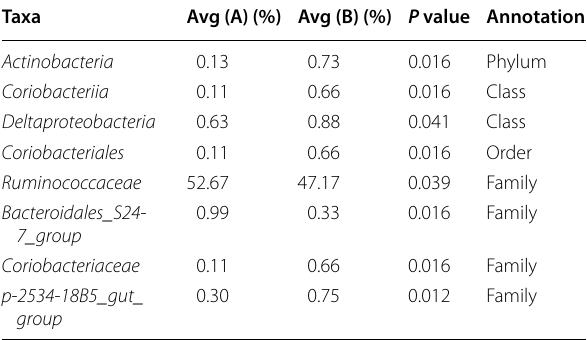
Table 3 Seasonal (winter and spring) comparisons for spe- cies abundance at the phylum, class, order and family